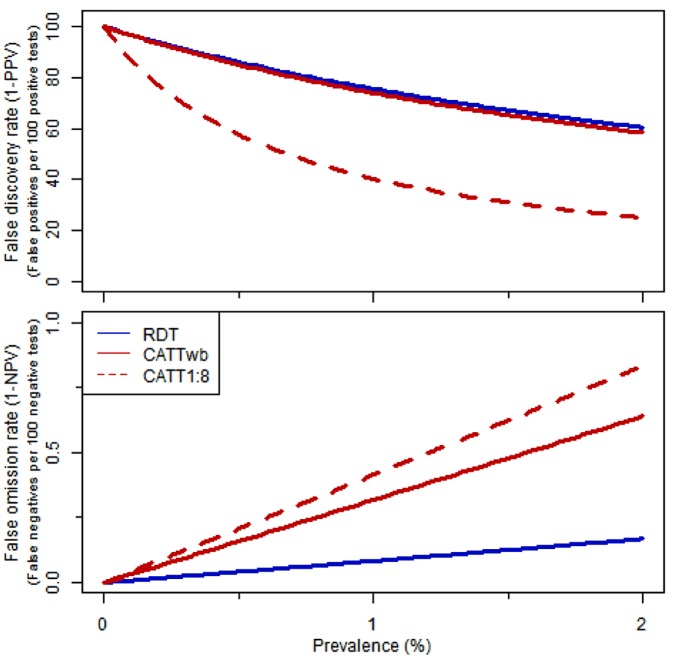
False discovery and false omission rates.FDR and FOR of each test followed by CRS over a range of prevalences, which were calculated based on the sensitivity and specificity of the algorithms that were found in this study.